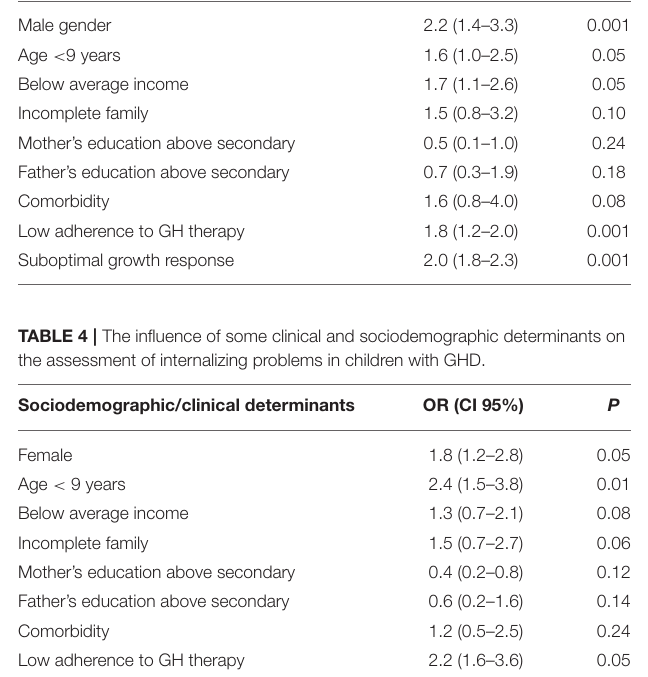
TABLE 3 | The influence of some clinical and sociodemographic determinants on the overall assessment of psychological problems in children with GHD. Sociodemographic/clinical determinants